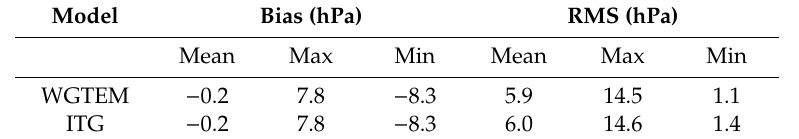
Table 4. Bias and RMS of air pressure results from different models validated by NOAA data.